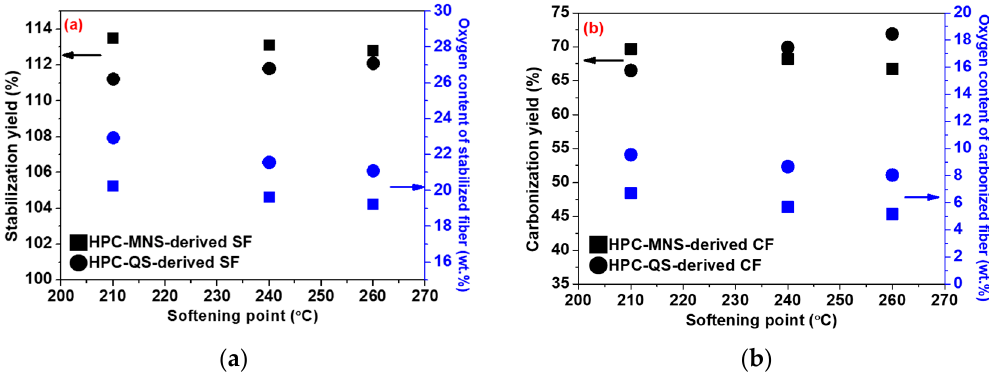
Figure 8. Yield and oxygen contents of ( a ) SFs and ( b ) CFs.